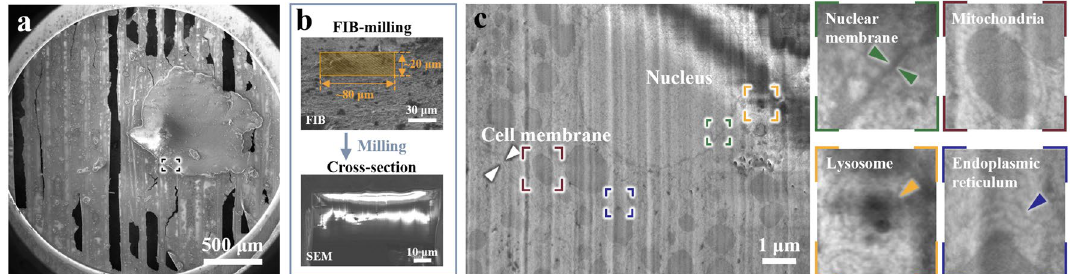
Figure 2. CSEI-based localization on a liver slice. ( a ) Selected region (black box) for CSEI on a liver tissue slice, shown by low-magnification SEM. ( b ) Large window (orange box in the top image, under FIB view) milled for CSEI (bottom image). ( c ) Magnified CSEI area on the surface created by cryoFIB milling of ( b ) showing high contrast features of liver cells. The cell membrane (white arrow) and multiple organelles (colorful boxes and corresponding magnified images shown on the right) in liver cells were observed. All images of CSEI were acquired using Crossbeam 550 (ZEISS